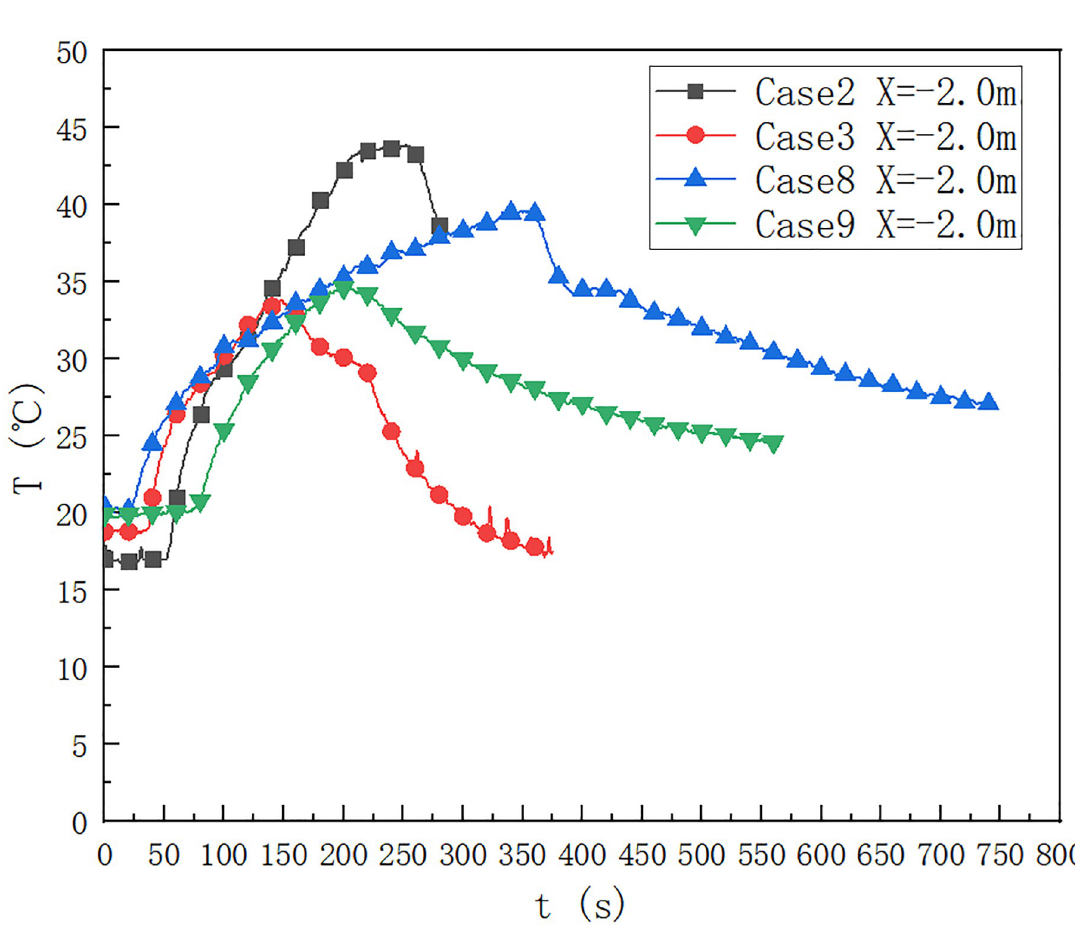
Fig 8. Temperature change below the ceiling of the cable compartment in the utility tunnel at 2,3,8 and 9 at a distance of -2.0 m from the fire